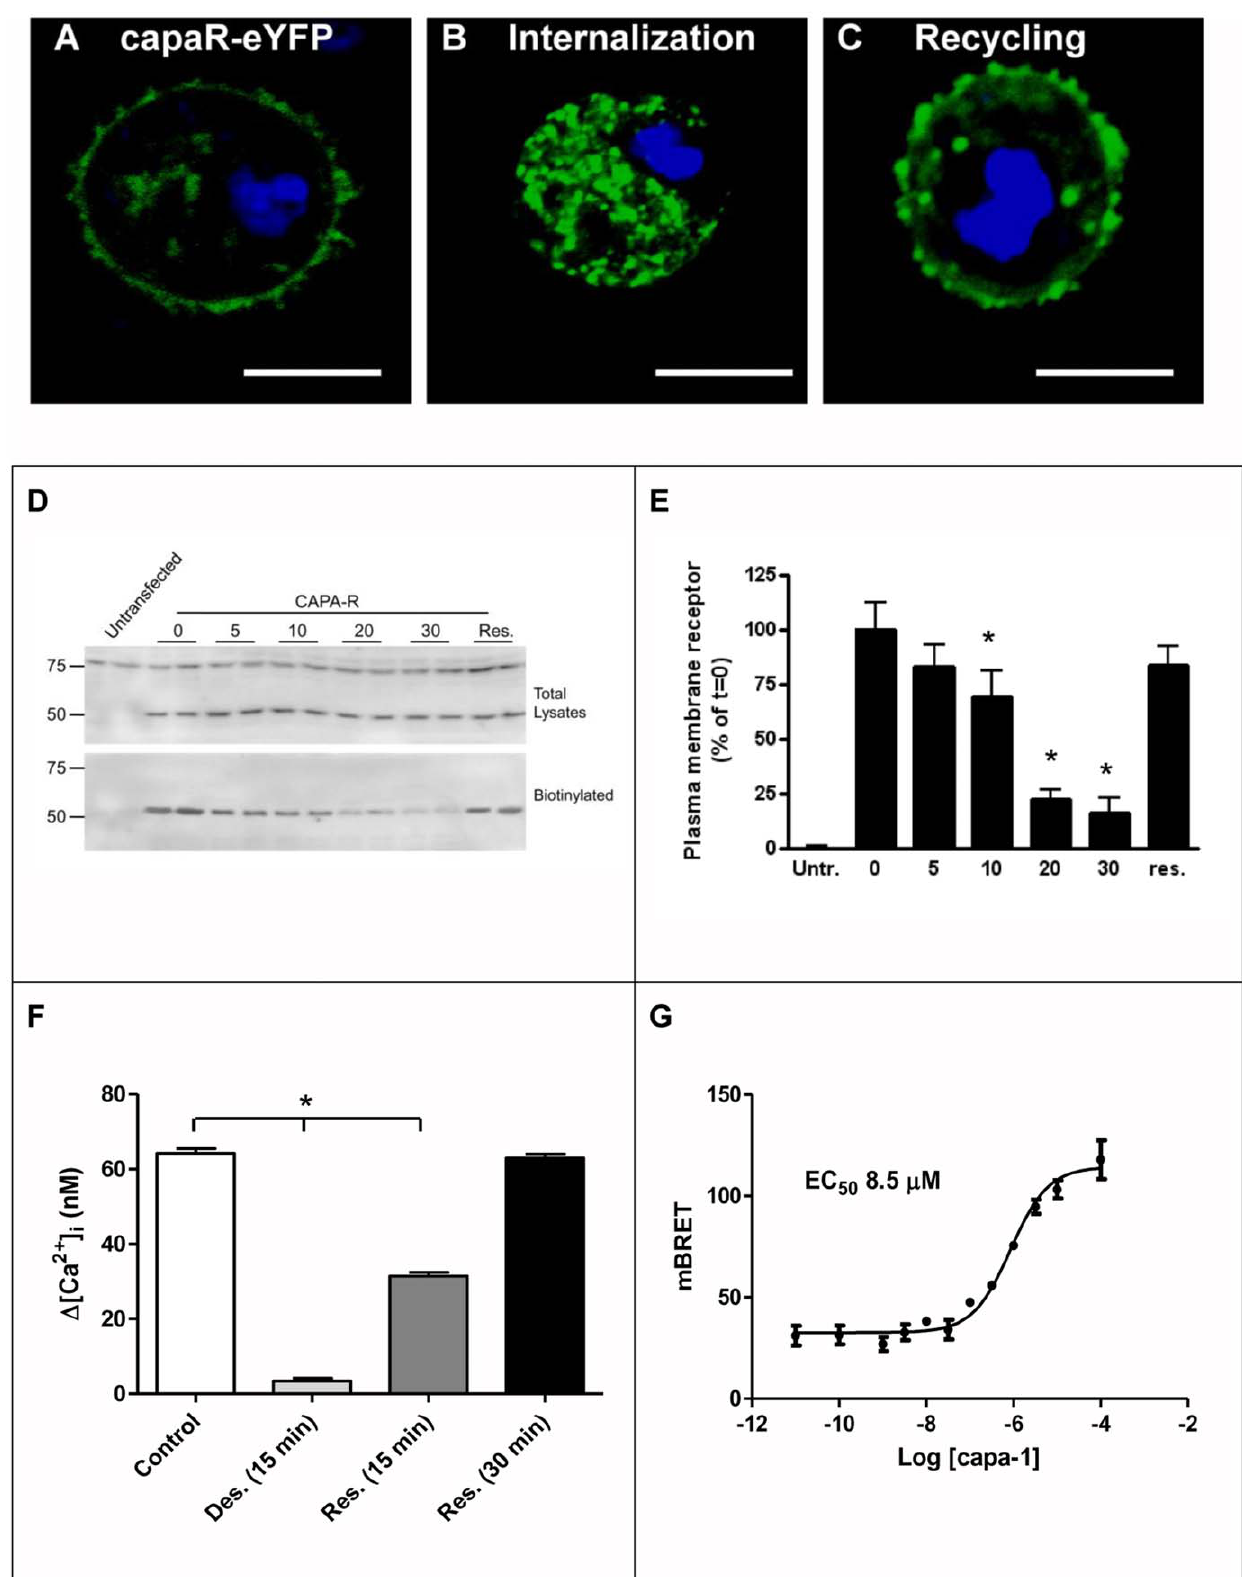
Figure 2. Desensitization and internalisation of capa-1-stimulated capaR. S2 cells were transfected with eYFP-tagged capaR, left un-treated or treated with capa-1, and viewed by confocal microscopy after immunocytochemistry with anti-GFP antibody. ( A ) Control. ( B ) capa-1 stimulated, 15 min. ( C ) sample was incubated for 15 minutes with capa-1, washed three times with culture medium followed by 30 minutes incubation in culture